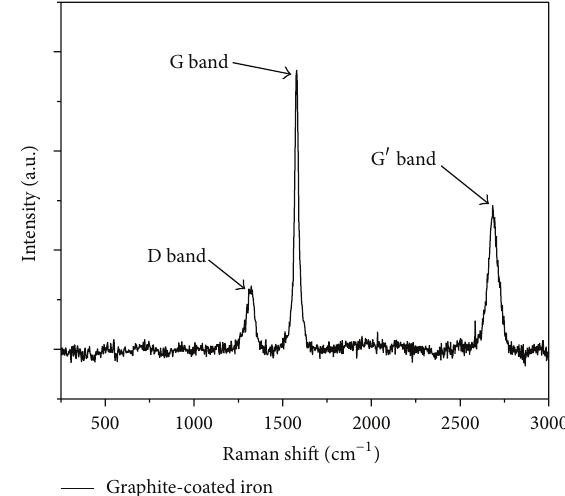
Figure 3: Raman spectrum of graphite-encapsulated iron nanopar-